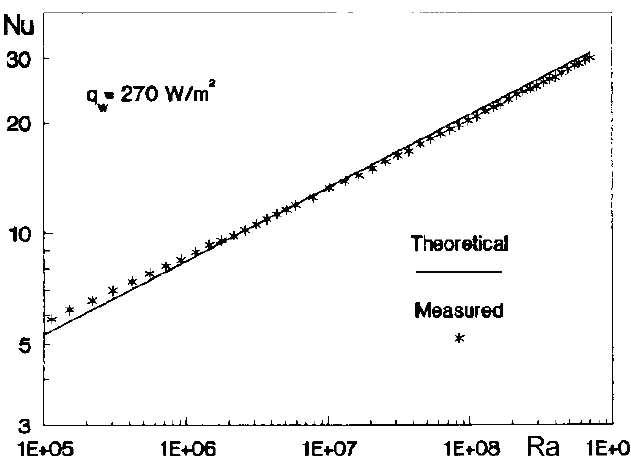
Figure 14. Nusselt number on a vertical plate cooled by natural convection as a function of the Rayleigh number. From Carlomagno and de Luca